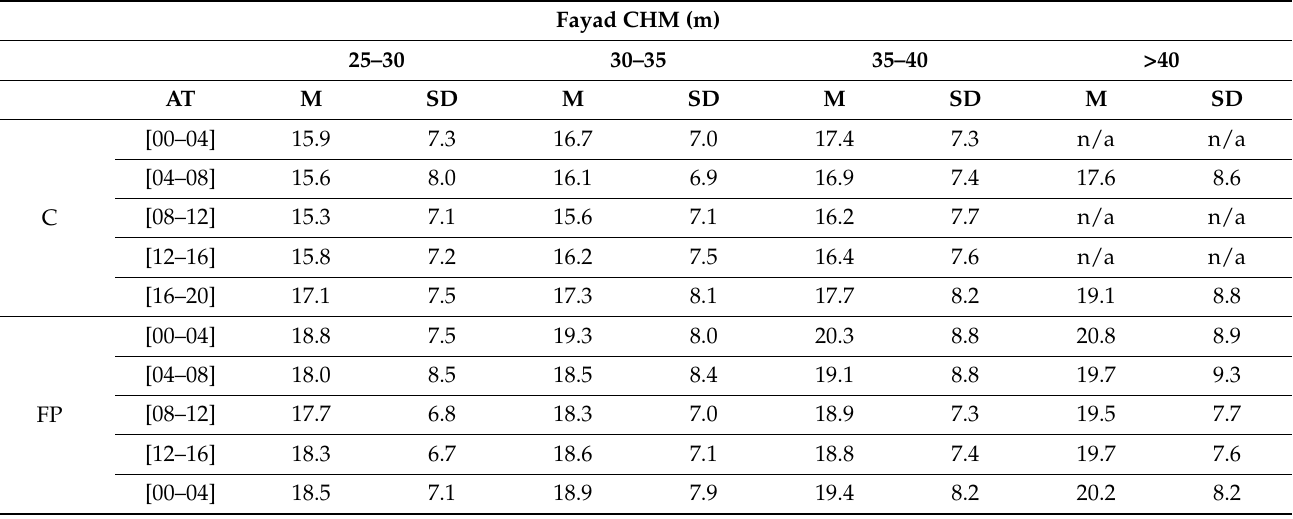
Table A6. Mean (M) and standard deviation (SD) in meters of the elevation difference between EHR and SRTM, grouped by different acquisition times and Fayad CHM. (C) and (FP) correspond to the ELM values from GEDI’s coverage and full-power lasers,